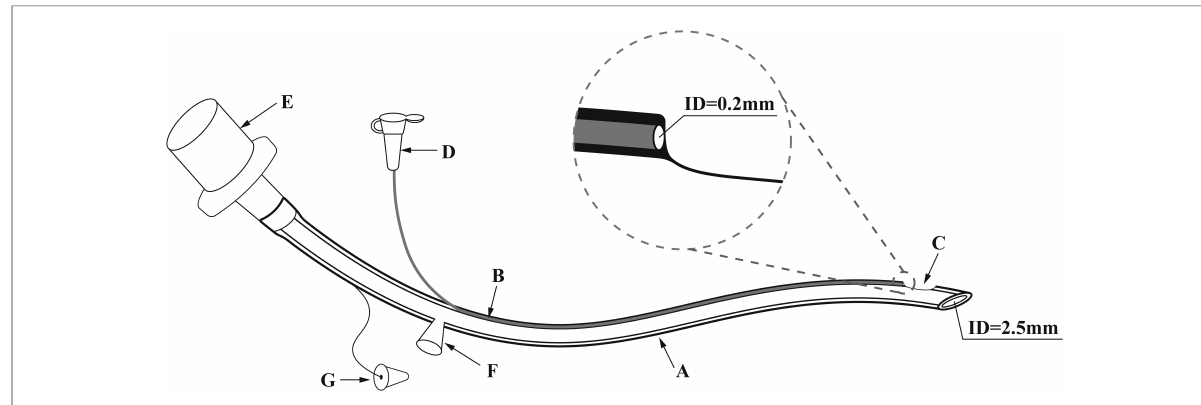
FIGURE 1 The novel doublt-lumen tracheal tube (take model 1 as an example.) ID: inner diameter. ( A ) The dominant tube, whose diameter is chosen according to the weight of the newborn. (Model 1: ID 2.5 mm; Model 2: ID 3.0 mm; Model 3: ID 3.5 mm; Model 4: ID 4.0 mm). ( B ) The drug delivery tube located inside the wall of the dominant tube, with an ID of 0.2 mm. ( C ) The Murphy Eye in direct communication with distal end of the drug delivery tube. ( D ) The plastic cap for closing the drug injection port. ( E ) The tube connector. ( F ) The aspiration cannula for the insertion of the suction tube. ( G ) The hole plug for closing the aspiration cannula when sputum aspiration is not required. In order to optimize the new double-lumen tracheal tube, the design of the aspiration cannula with its accompanying hole plug was eliminated in the actual production